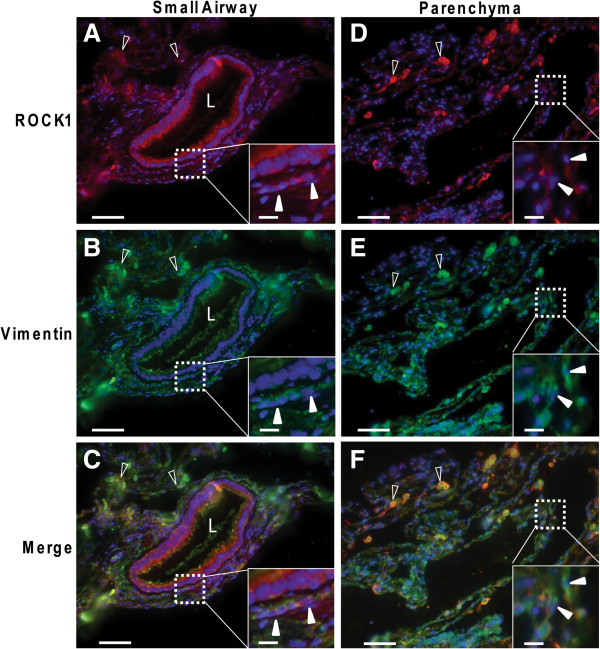
Double staining of vimentin and ROCK1. Immunostaining for ROCK1 (A and D) and vimentin (B and E) in COPD tissue sections. Cell nuclei are visualized by DAPI staining, shown in blue. (C) and (F) show merged images. (A), (B) and (C) show a small airway and (D), (E) and (F) alveolar parenchyma. Inserts show cells positive for both ROCK1 and vimentin with fibroblast-like morphology as indicated by closed arrowheads. Open arrowheads show rounded double-positive cells that are likely to be alveolar macrophages. Scale bars represent 50 μm of the larger image and 10 μm on inserts.